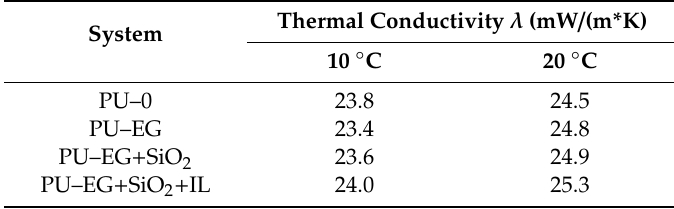
Table 4. Thermal conductivity coe ffi cient at a temperature di ff erence of 10 ◦